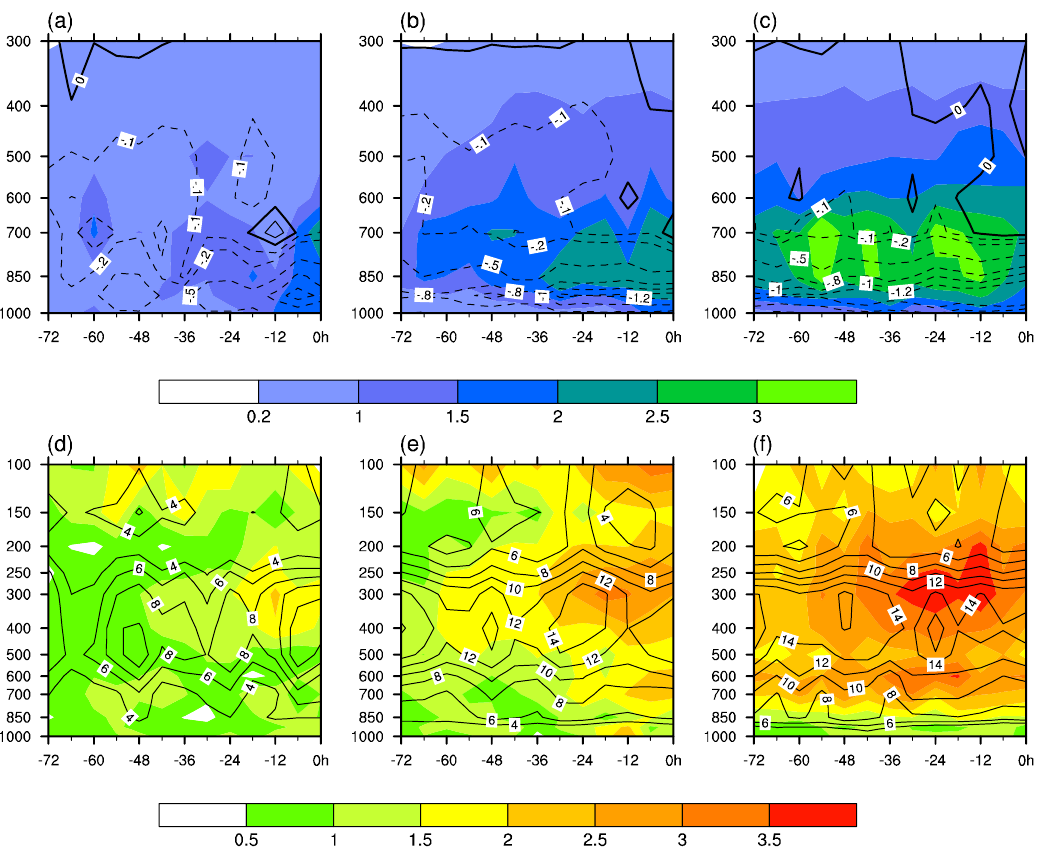
Figure 8. Same as in Figure 7, but for the vertical cross-section of wet ( a – c , g kg − 1 ) and warm ( d – f , K) core in shading. Contours in ( a – c ) and ( d – f ) are water vapor flux divergence (10 − 4 kg m − 2 s − 1 ) and diabatic heating rate (K d − 1 ) averaged by the 5° × 5° grid box centered on typhoon, respectively.